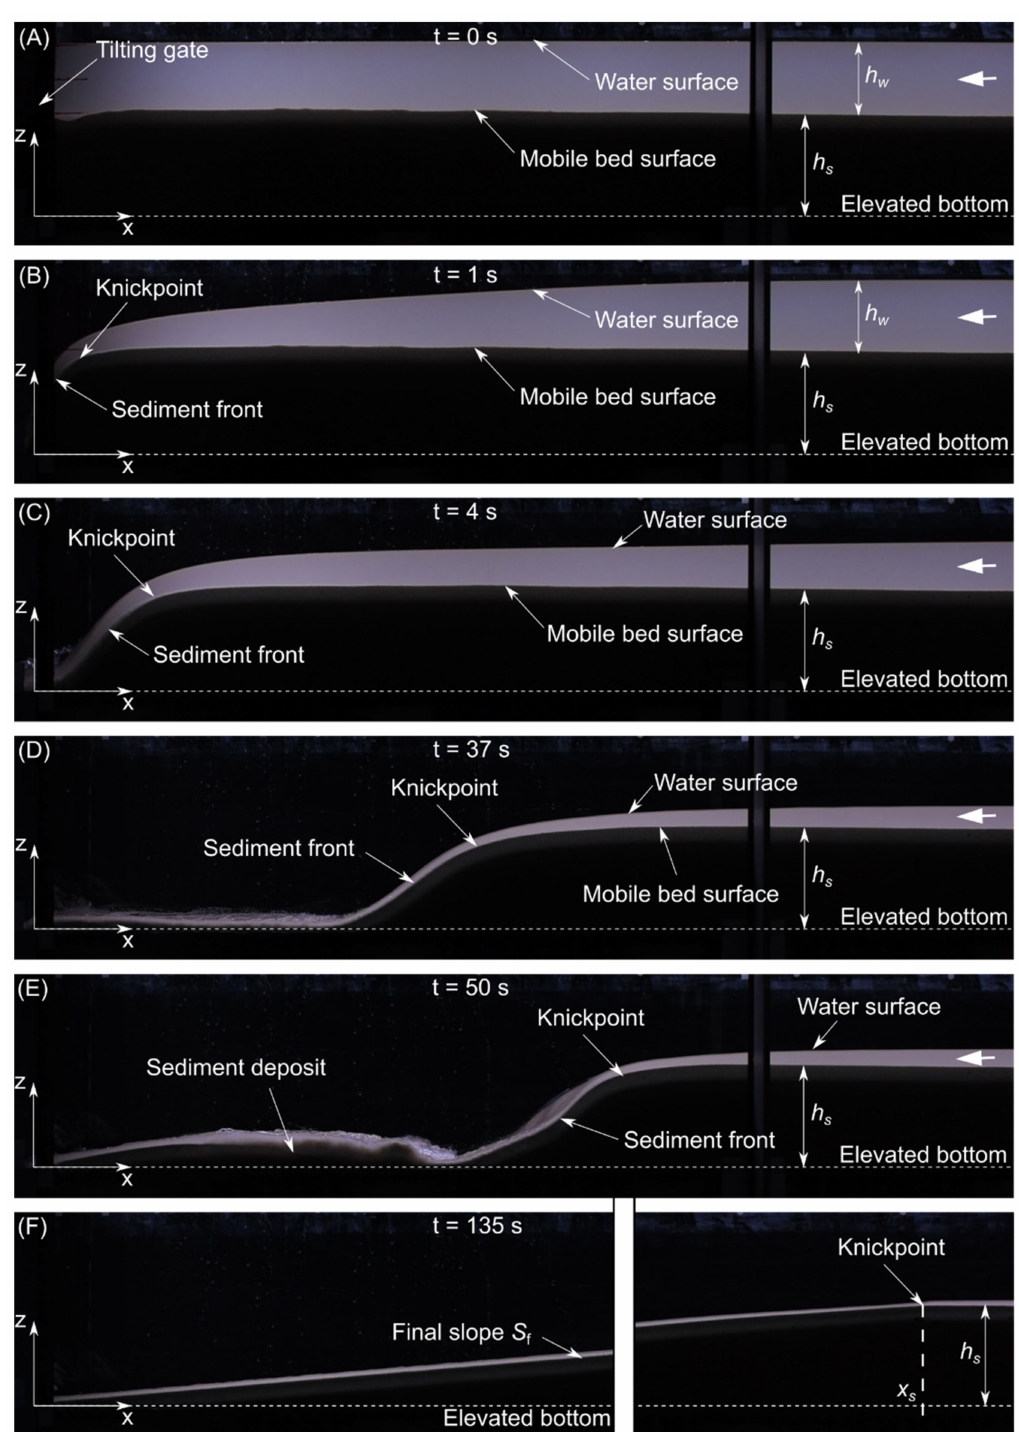
Figure 4. Longitudinal profiles of the bed surface and water surface for the experiment performed with fine sand, h w · L/h s2 = 26.65, V w /h s 3 = 54.73, and S 0 = 0.0% at the instants: ( A ) t = 0 s, ( B ) t = 1 s, ( C ) t = 4 s, ( D ) t = 37 s, ( E ) t = 50 s, and ( F ) t = 135